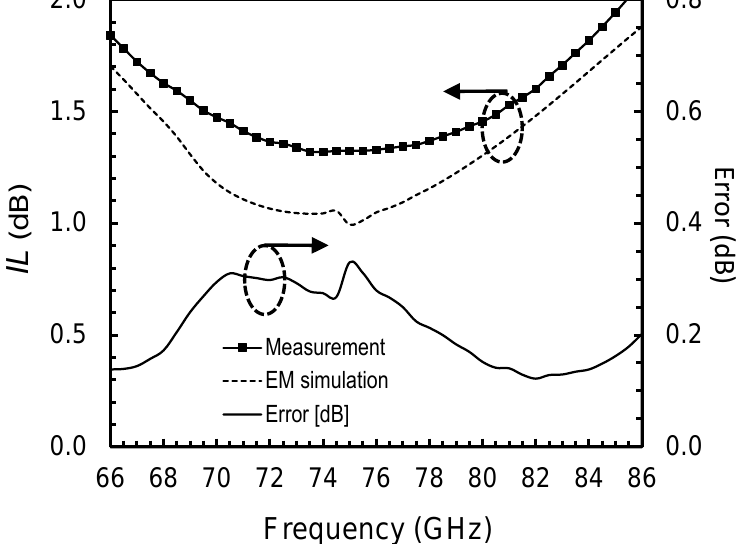
Figure 6. Simulated and measured insertion loss ( IL ), and corresponding error in dB of transformer T R .